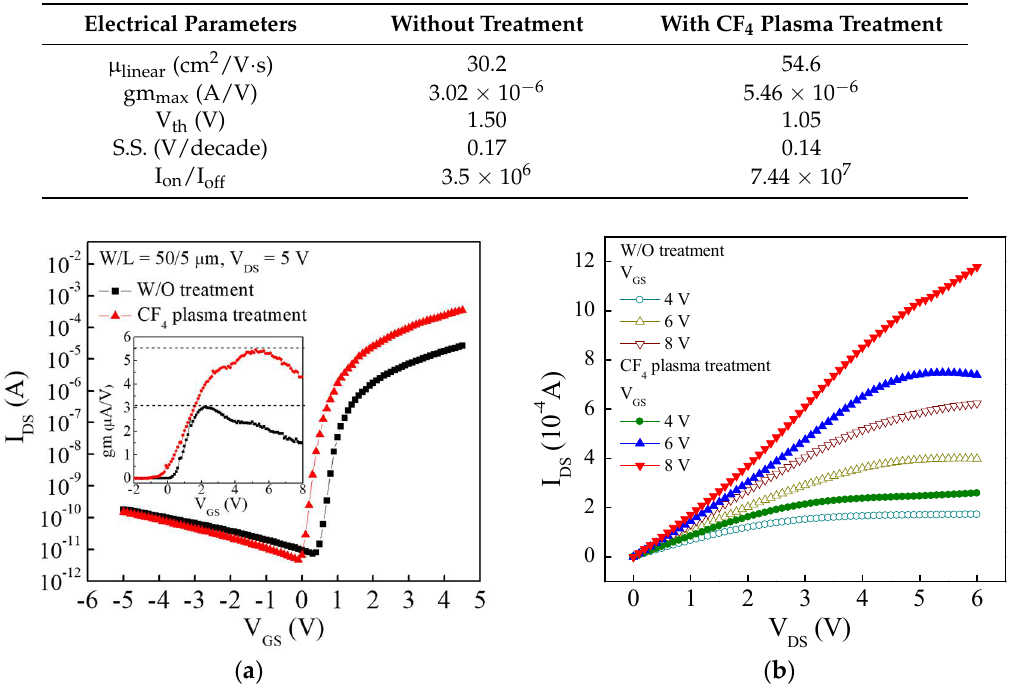
Table 1. Effects of the CF 4 plasma treatment on electrical performance parameters of the fabricated a-IGZO TFTs with HfO 2 gate dielectric. Electrical Parameters Without Treatment